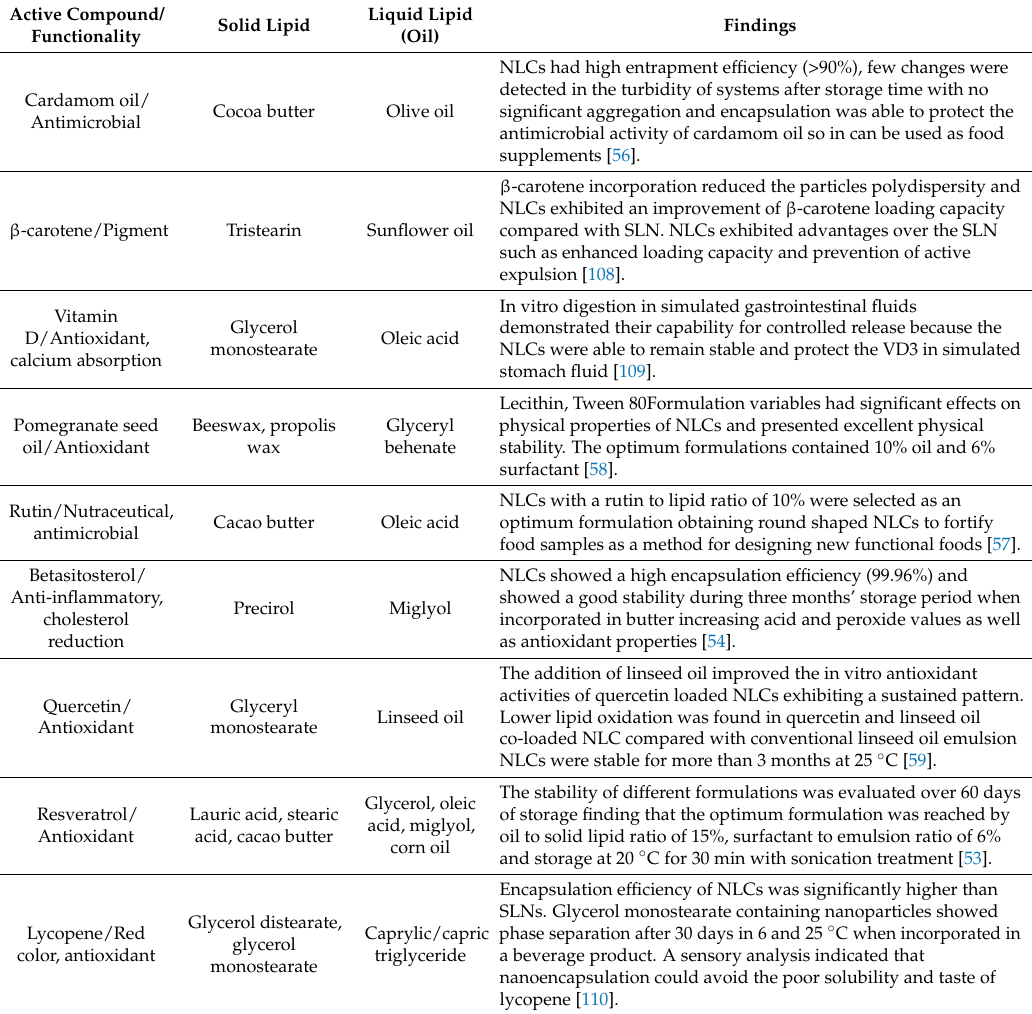
Table 3. Active compounds incorporated into NLCs for applications in food